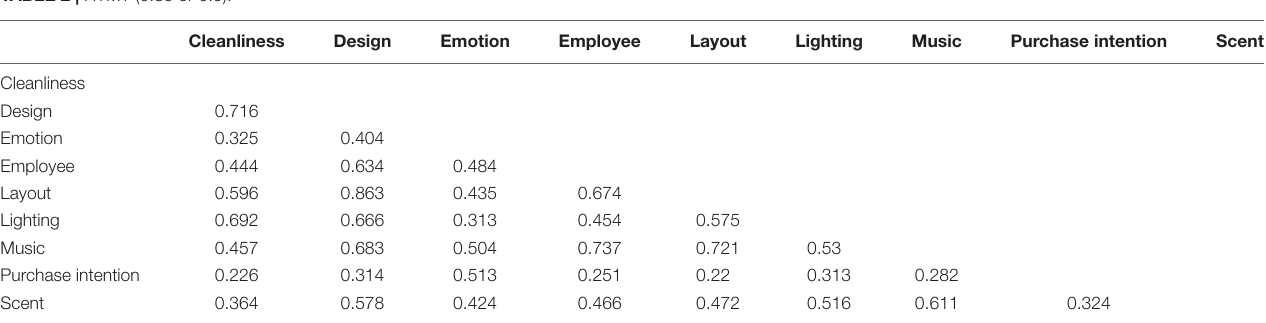
TABLE 2 | HTMT (0.85 or 0.9).